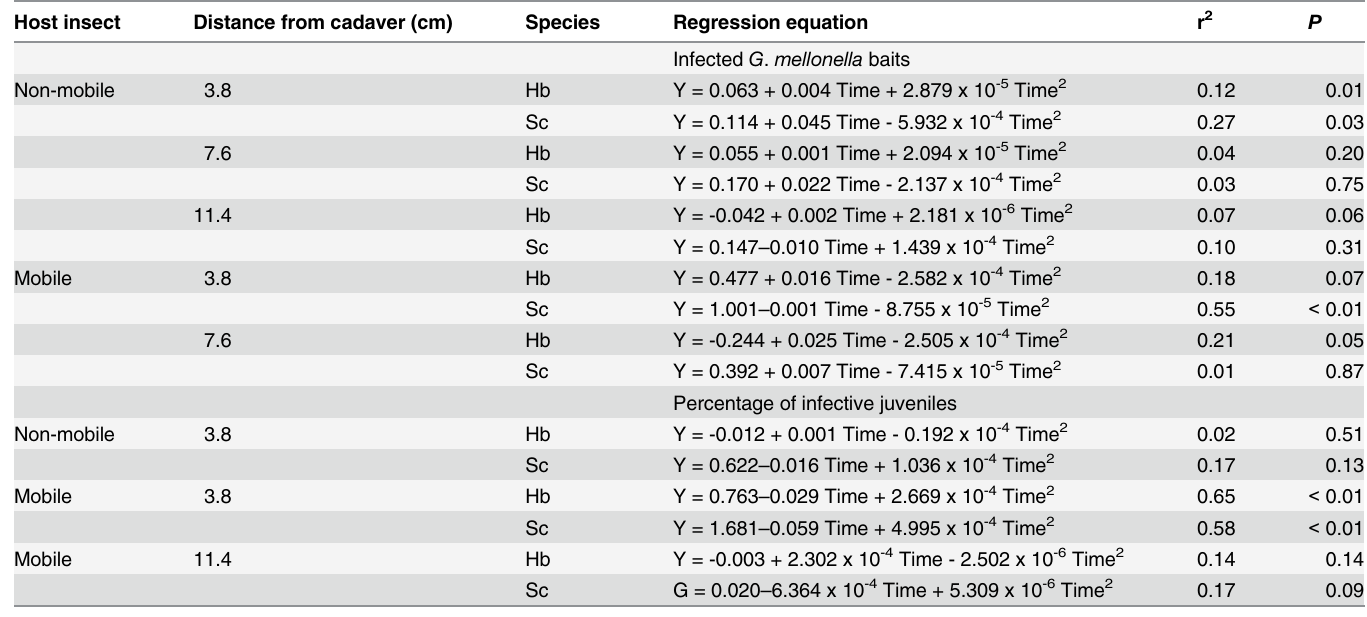
Quadratic regression lines fi tted for the mean number of Galleria mellonella baits infected by Heterorhabditis bacteriophora (Hb) and Steinernema carpocapsae (Sc) and mean percentage of IJs of the two species at a particular distance from the source cadaver in a microcosm over a period of 12 to 72 hr in the presence of non-mobile and mobile